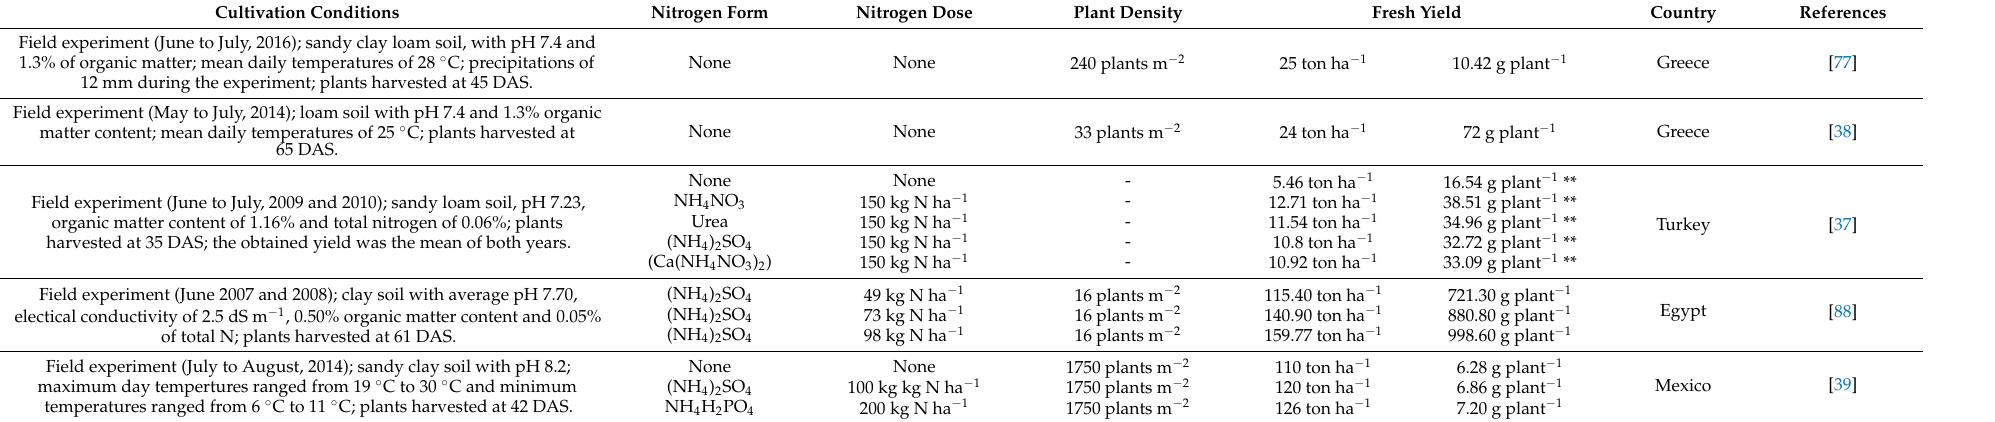
Table 3. The effect of different nitrogen forms, rates and density of plants in yield experiments with Portulaca oleracea